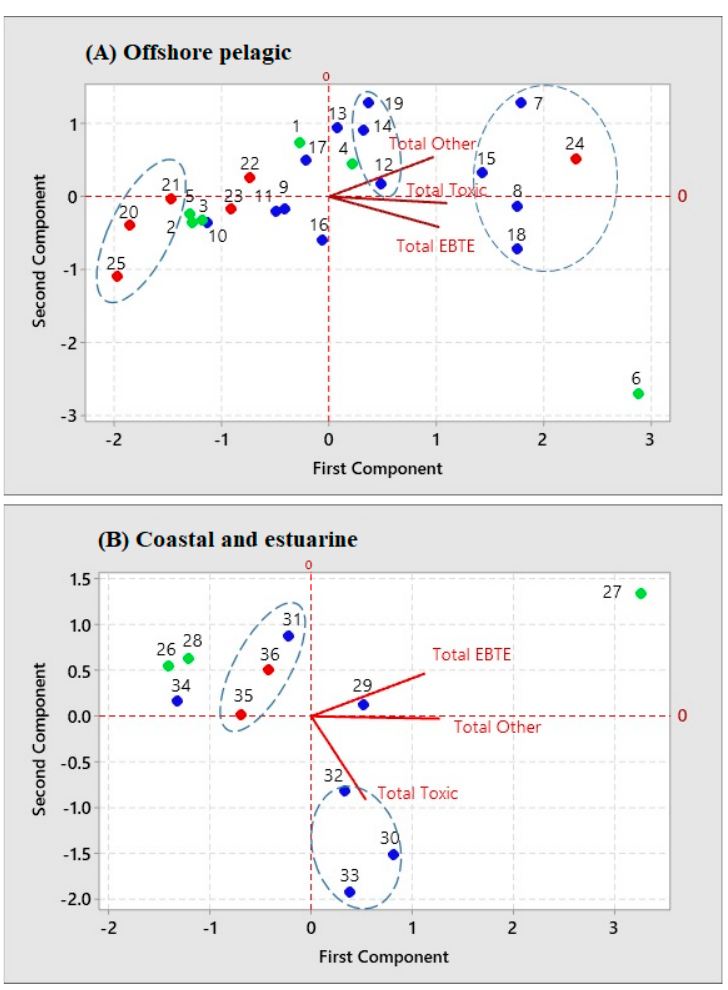
Figure 3. PCA biplot of elements (total EBTEs: essential but toxic in an excess amount, total NETs: non-essential toxic, and total Other) in muscle samples of offshore pelagic ( A ) and coastal and estuarine ( B ) organisms caught in Sri Lanka. Green: lower, blue: middle, and red: higher trophic level.